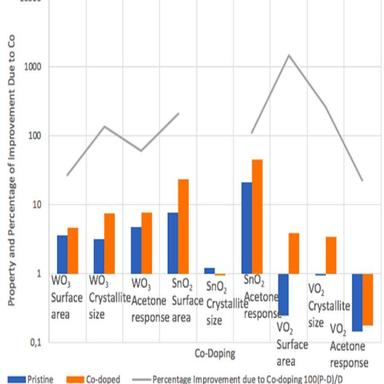
Effects of cobalt doping on surface area, acetone response, and crystallite size. (For interpretation of the references to colour in this figure legend, the reader is referred to the web version of this article.)